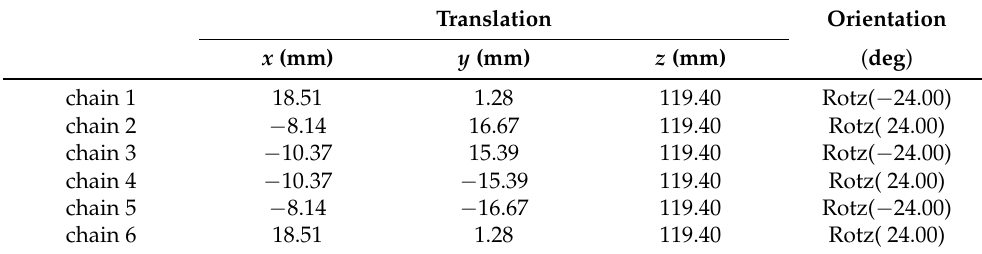
Table 2. Initial rigid displacement of each